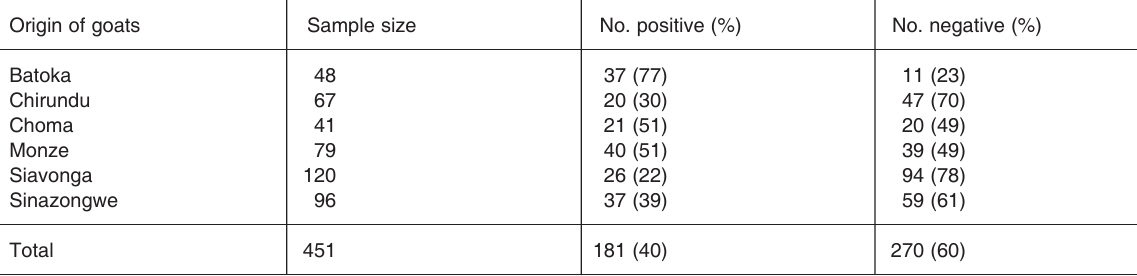
TABLE 3 MAP-1B indirect ELISA analysis of goat sera for heartwater Origin of